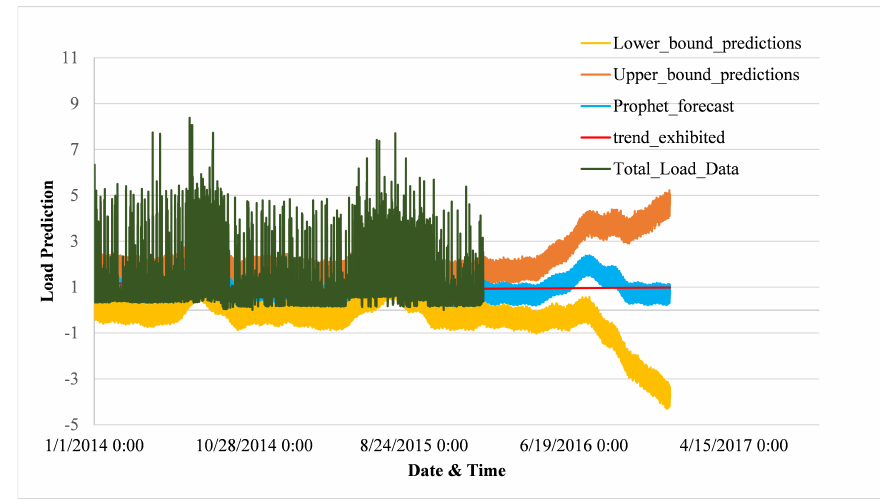
Figure 9. Prophet forecast analysis between the actual and predicted data.